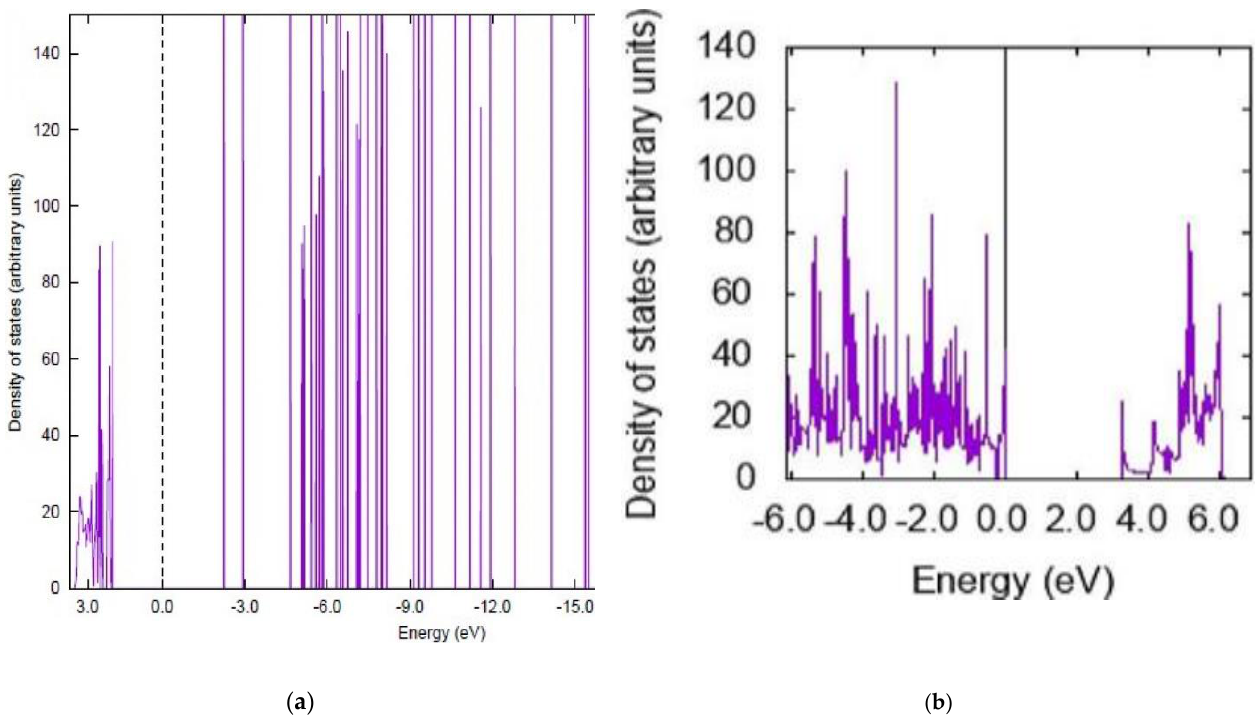
Figure 3. DOS for a (5,5) BNNT-curcumin complex; ( a ) inside position, and ( b ) outside position.